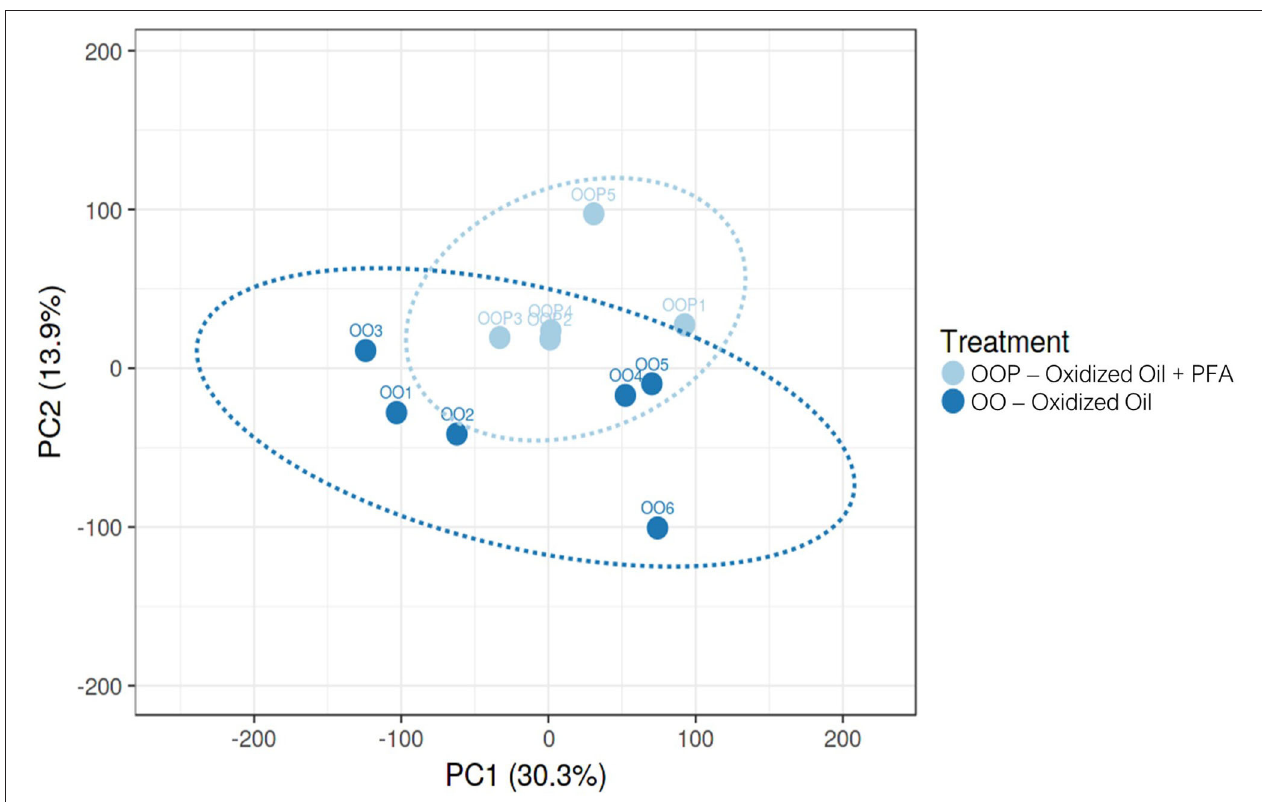
FIGURE 3 | Principal component analysis on mRNA expression in the liver of piglets fed Oxidized Oil (OO) diet or Oxidized Oil + Phytogenic Feed Additive (OO + PFA). Analysis performed with Clustvis (prediction ellipses with 95% confidence interval). One piglet from the OO + PFA group was excluded from the RNA-Seq analysis due to technical issues observed during read quality